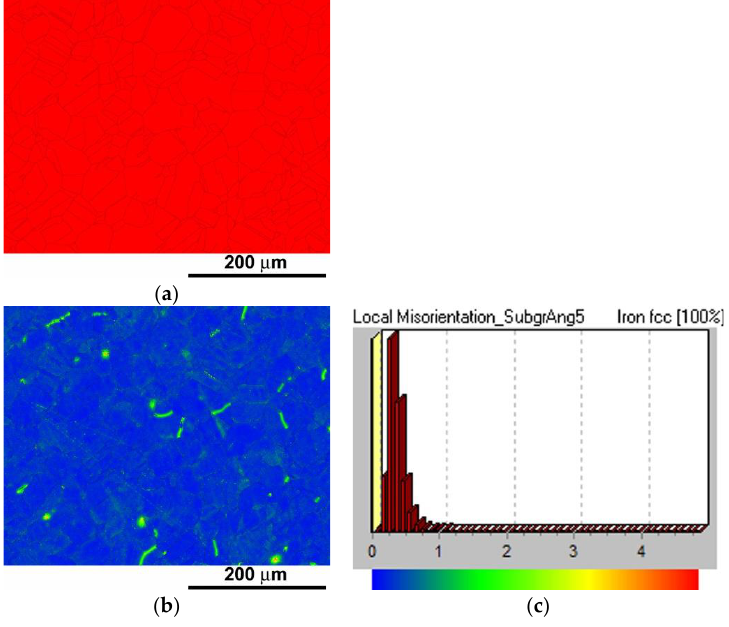
Figure 5. Complementary EBSD analyses of as-received 316H material: ( a ) phase map, ( b ) local misorientation map, and ( c ) corresponding LMM legend.